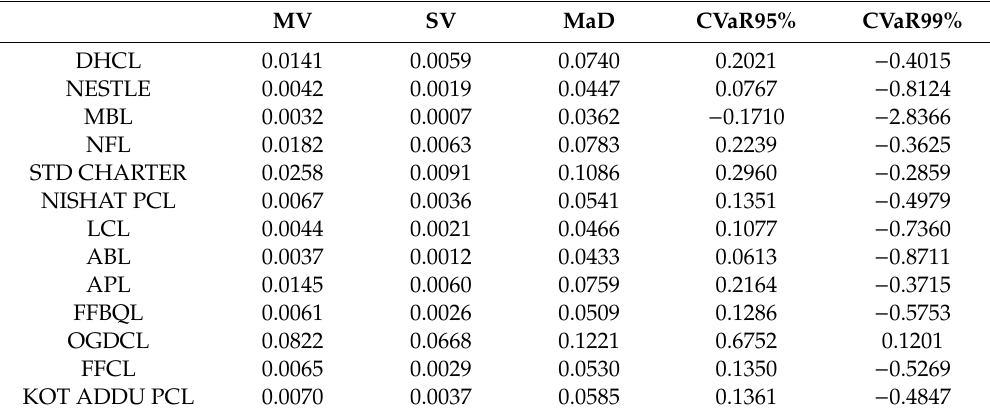
Table 3. Optimal portfolio compositions for economic growth period (2012–2015).